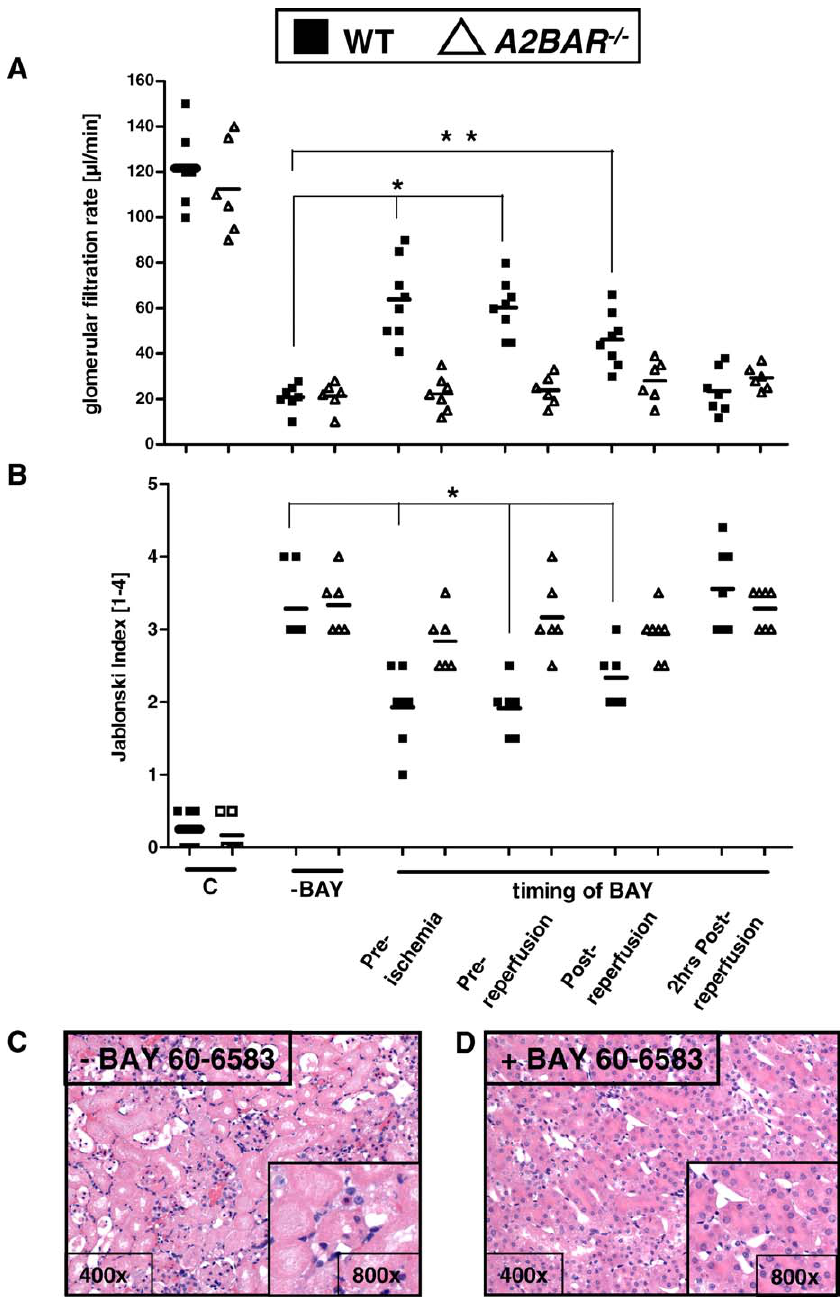
Figure 8. A2BAR Agonist (BAY 60–6583). A2BAR (cid:2) / (cid:2) Mice or Age-, Weight-, and Gender-Matched Littermate Controls Underwent Right